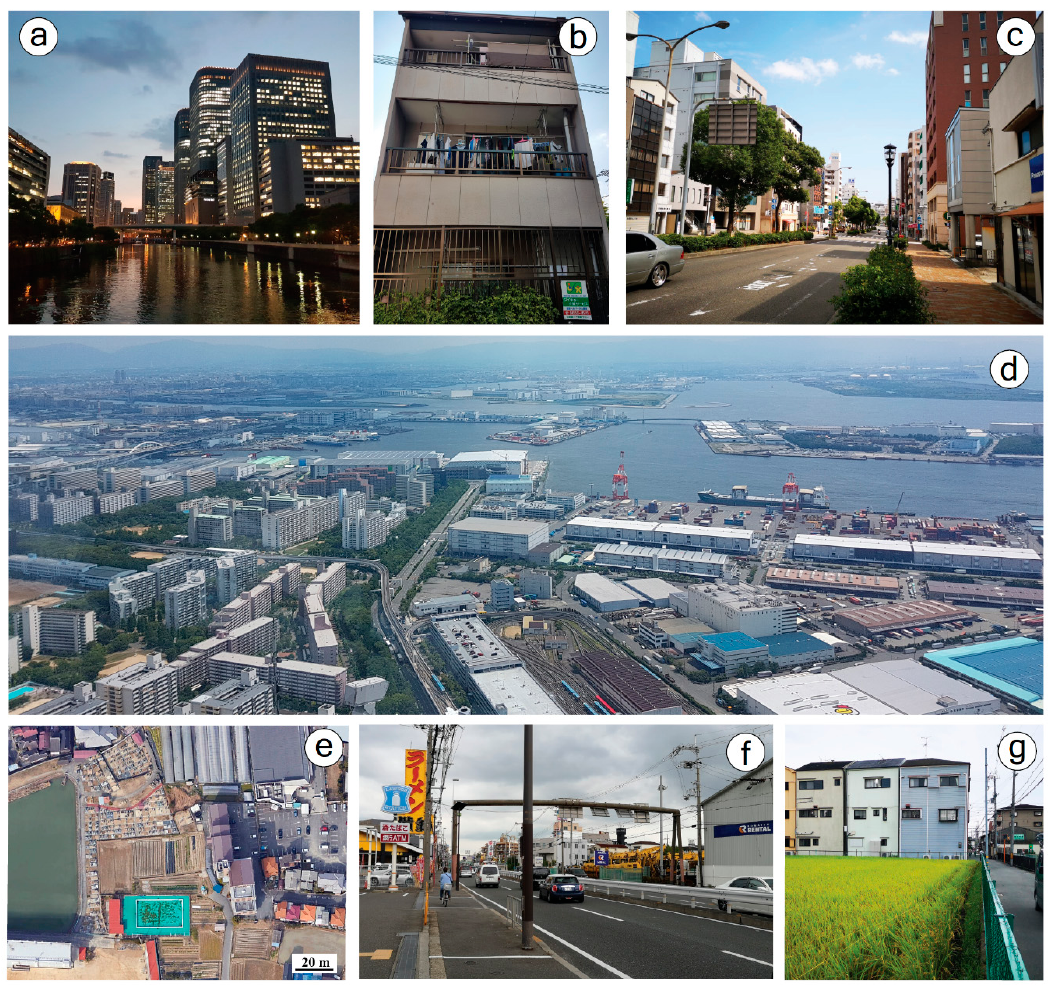
Figure 5. Picture set 1 (Locations: ( a) : Ch ūō -ku ward, ( b) : Nishinari ward, ( c) : Hy ō go-ku ward, ( d) : Suminoe-ku ward, ( e) : Habikino municipality, ( f) and ( g) : Neyagawa municipality).